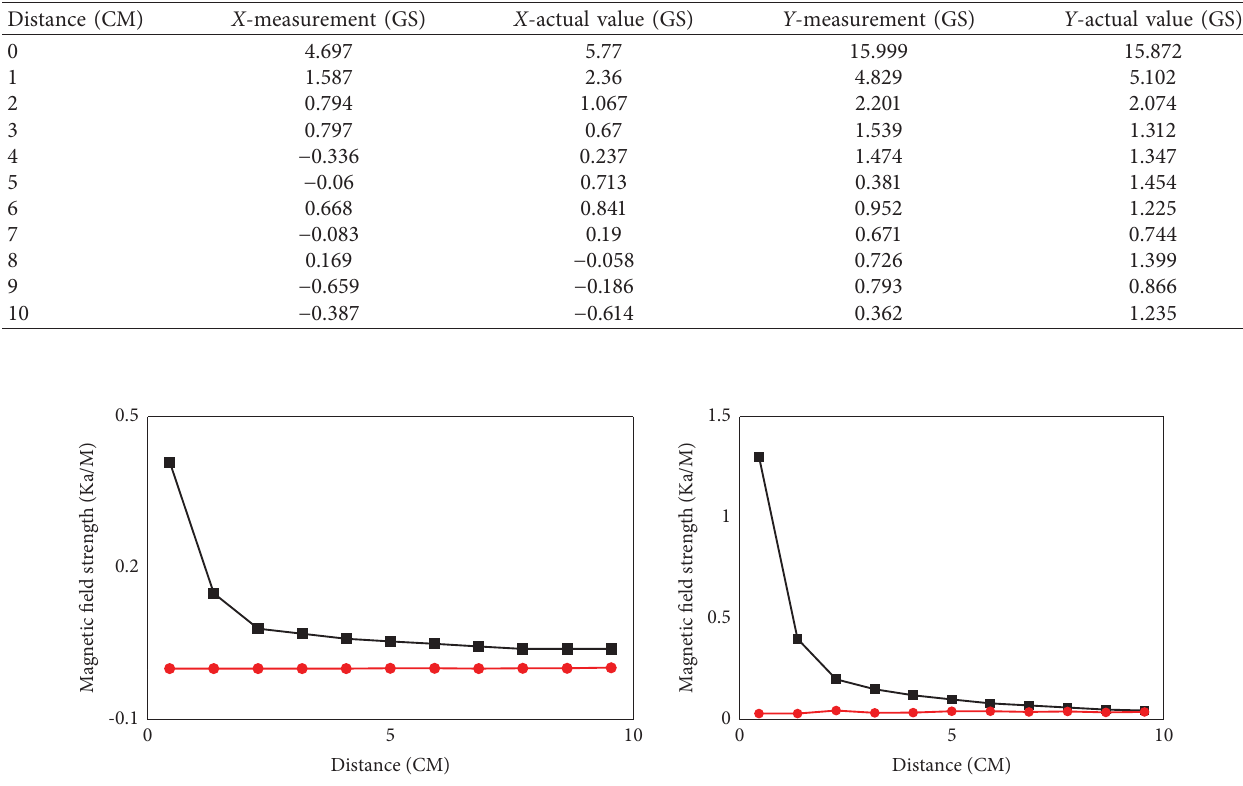
Table 3: Magnetic induction intensity of loop cable during operation.